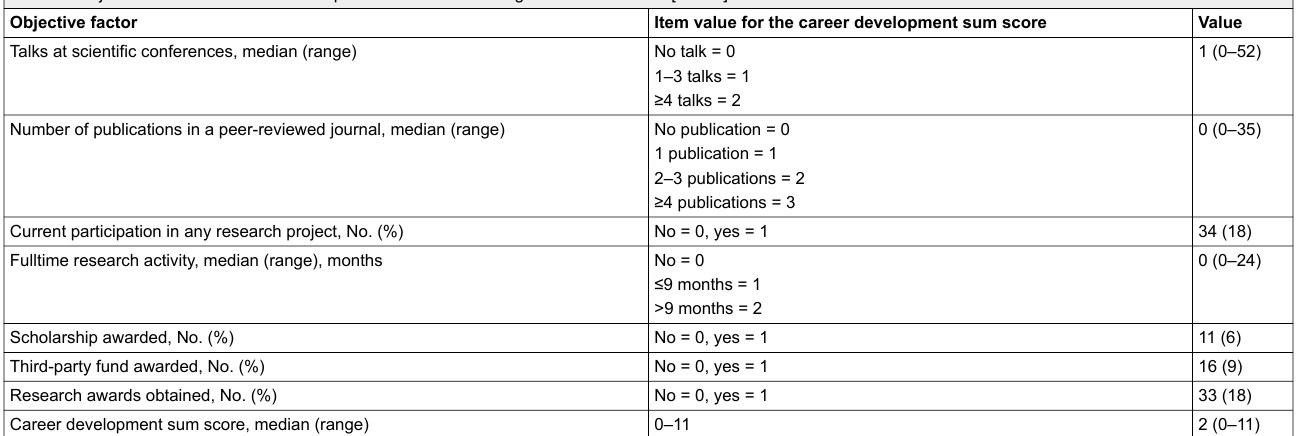
Table 1: Objective factors for career development in 189 female surgeons and residents [32–35]. Objective